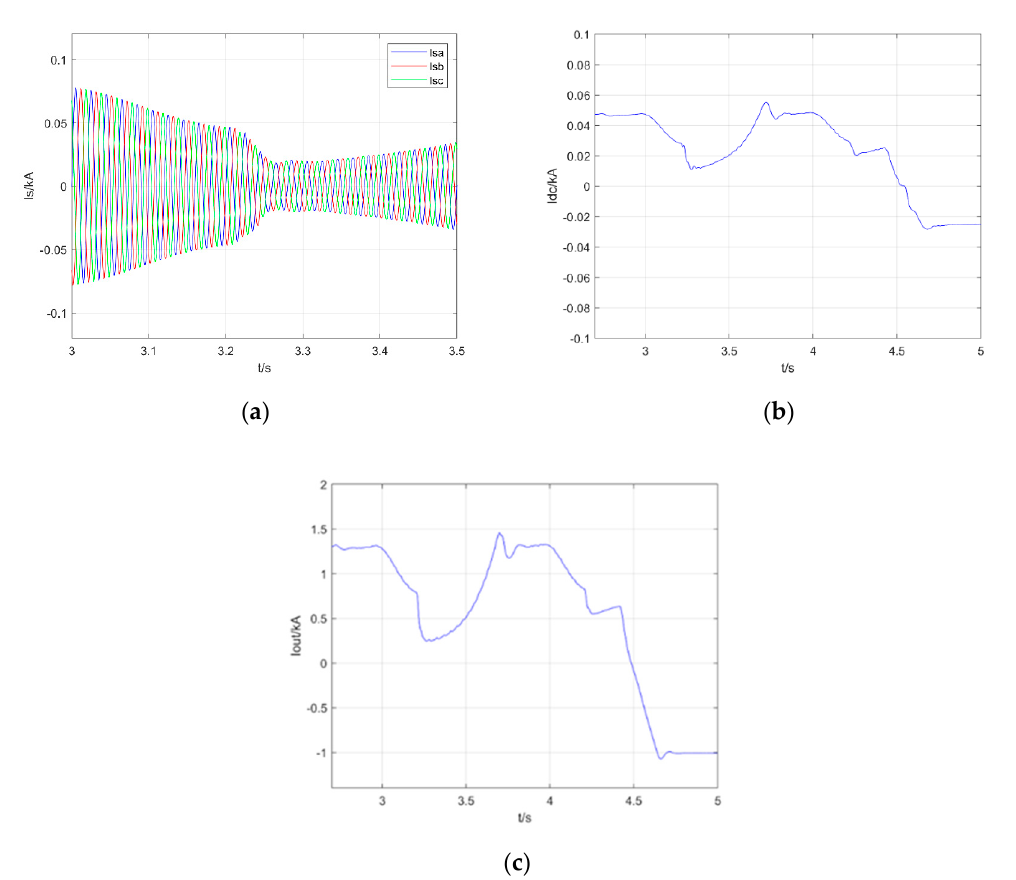
Figure 14. The current waveform of the SST under continuous power fluctuation: ( a ) the distribution network current; ( b ) the HVDC-link current; ( c ) the LVDC-link current.